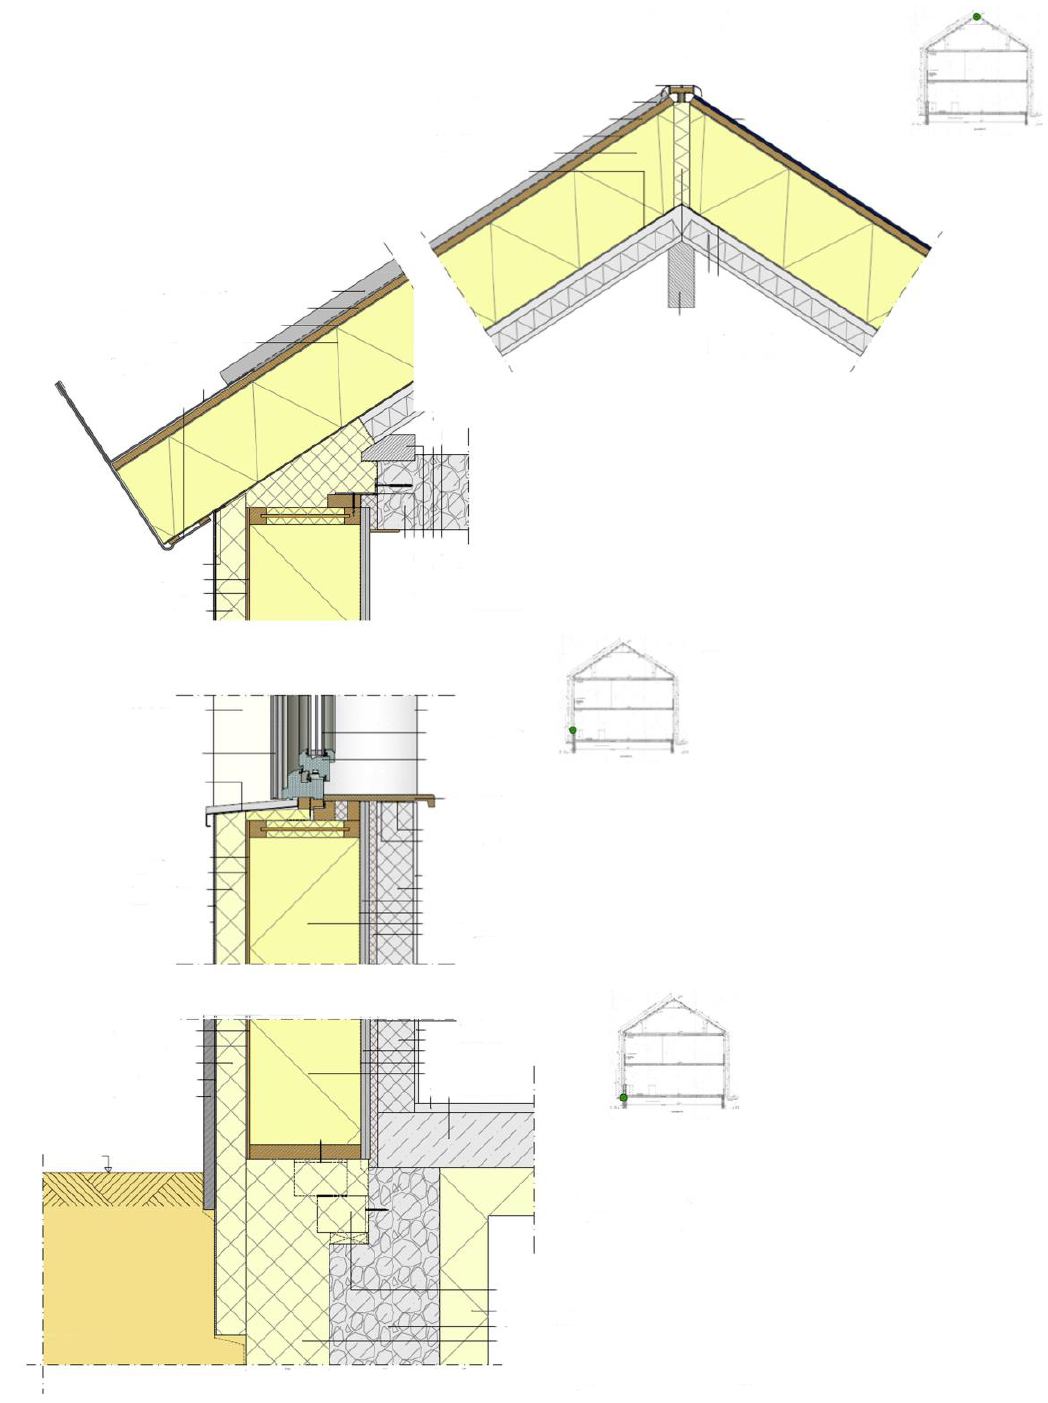
Figure 1. Passive house level renovation in a local project showing the large additional layer of materials needed for energy reduction only (yellow)